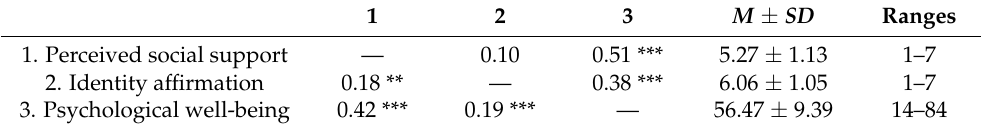
Table 2. Descriptive statistics and partial correlations between perceived social support, identity affir- mation, and psychological well-being in cisgender and non-binary people with bisexual orientation.